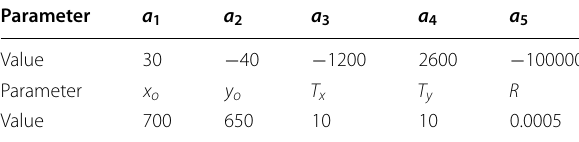
Table 1 Parameters of artificial displacement